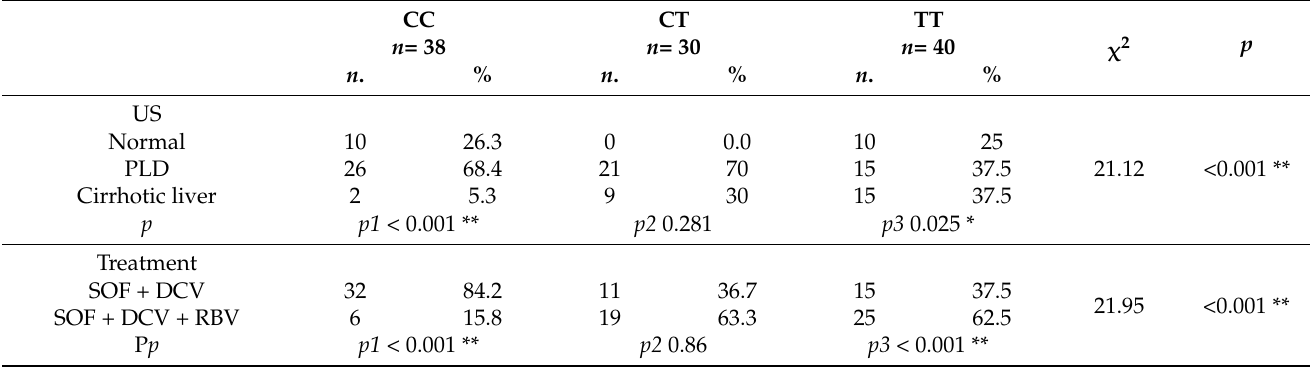
Table 5. The relation between IL28B (rs12979860) genotype, ultrasound findings of the liver, and treatment